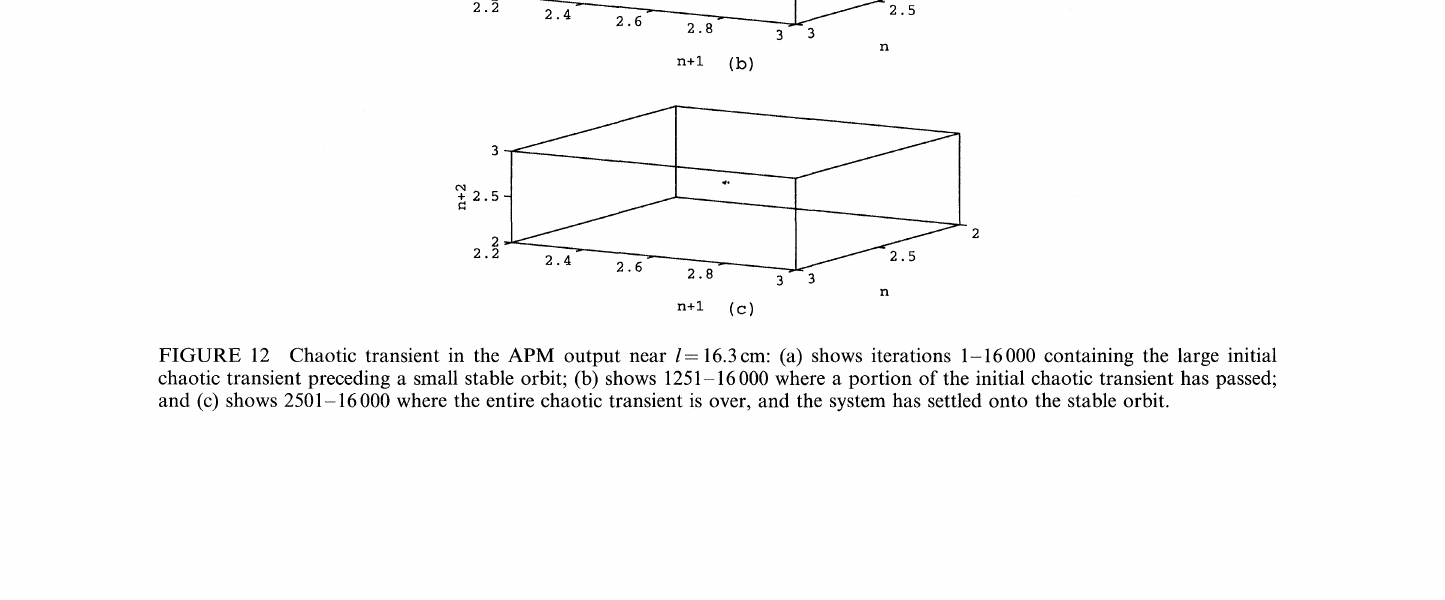
FIGURE 11 Reconstructed chaotic attractor in three dimensions for l 16.83-17.12cm.